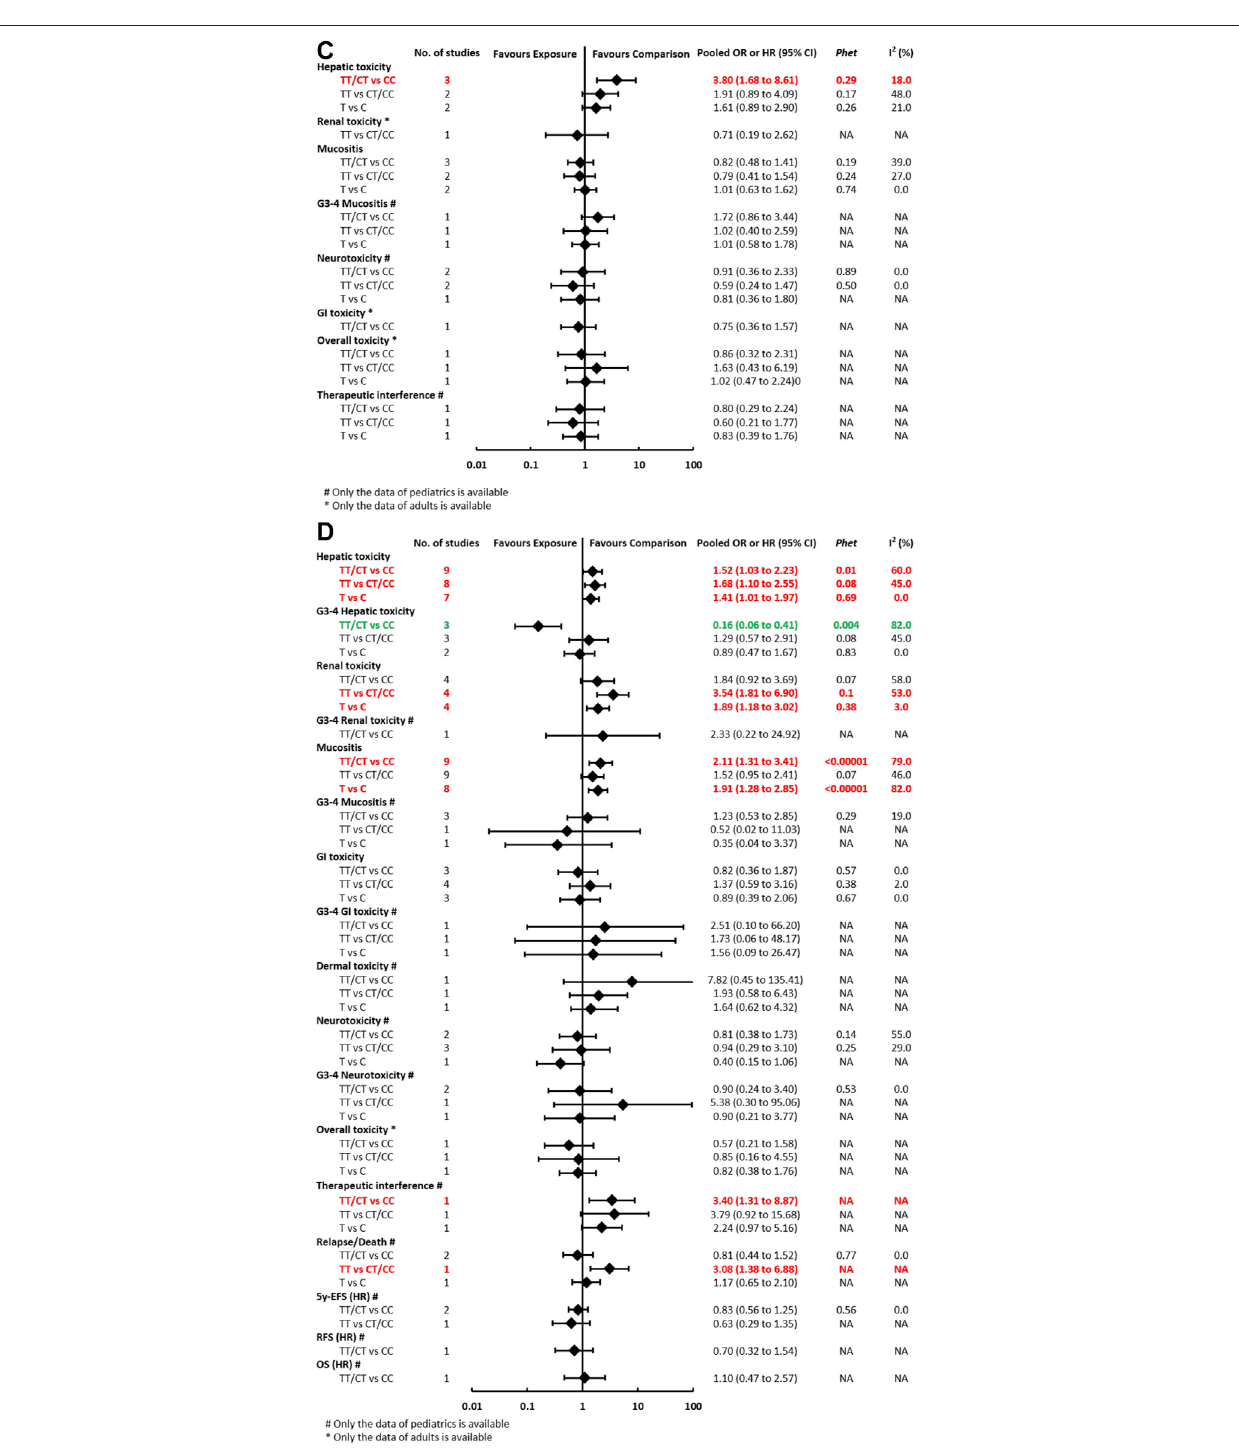
Frontiers in Pharmacology |